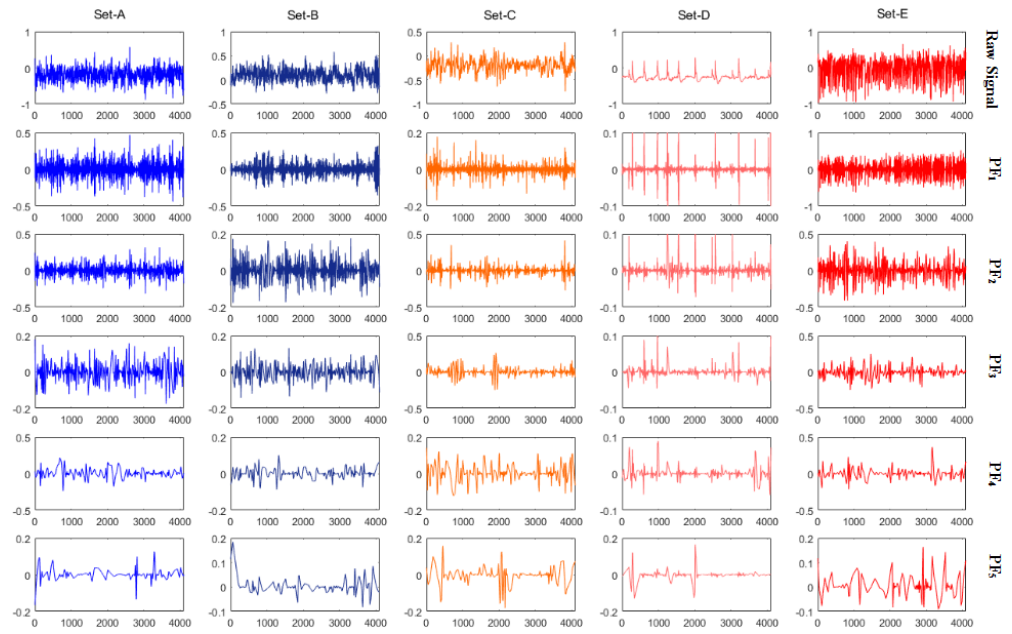
Figure 4. Sample Electroencephalographic (EEG) segments of five datasets (datasets A – E ) and their corresponding product functions (PFs) (PF1 to